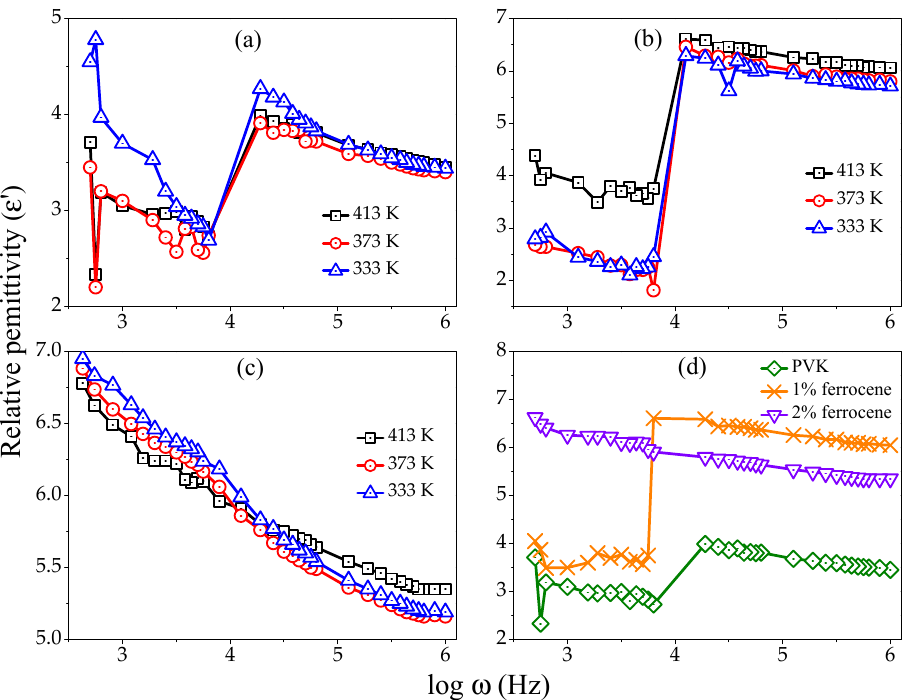
Figure 2. Variation of real part of dielectric constant ( ε (cid:48) ) as function of frequency for ( a ) pure PVK, ( b ) 1% ferrocene doped PVK, ( c ) 2% ferrocene doped PVK, and ( d ) at 413 K for pure and doped